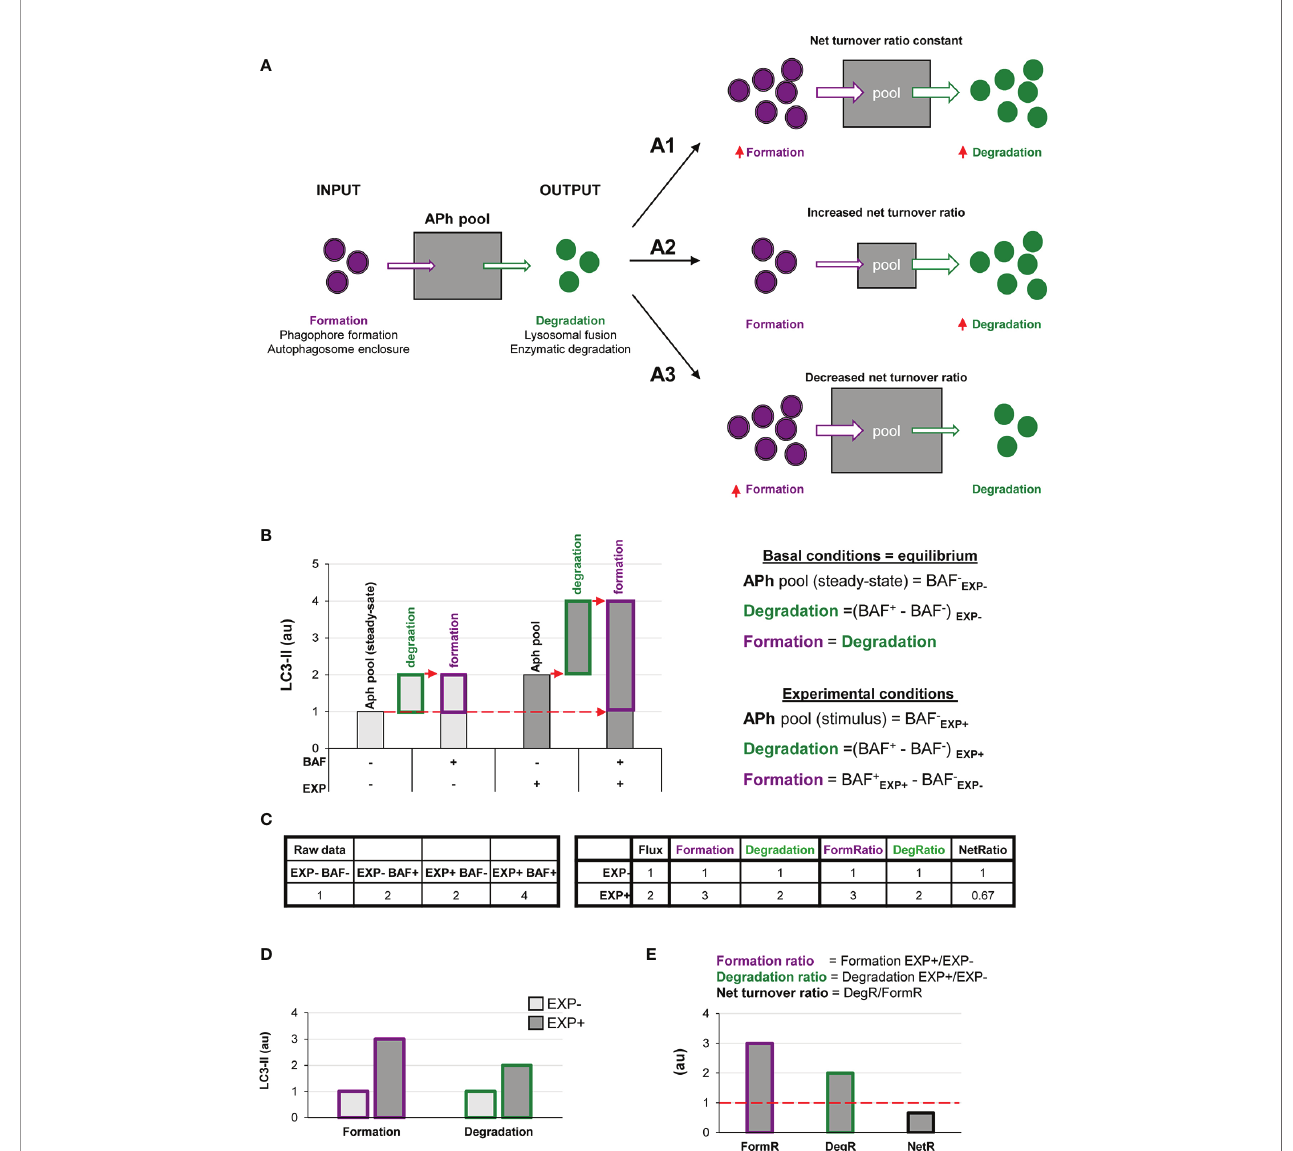
FIGURE 2 | A two-step model of autophagy to analyze formation and degradation of autophagosomes. (A) The model represents the autophagosomes as a box with an input (autophagosome formation, purple dots) and an output (autophagosome degradation, green dots) that determines the autophagosome net turnover. A1 – A3 represent different possible scenarios with no changes (A1), an increase (A2) and a decrease (A3) in the autophagosome net turnover. (B) Graph representing the amount of LC3-II (au, arbitrary units) in two experimental conditions representing (EXP - and EXP + ) in the presence or absence of the lysosomal inhibitor ba fi lomycin (BAF - and BAF + ), and the formulas used to calculate formation, degradation, and net turnover. The dotted red arrows mark the LC3-II raw data values used to calculate the formation and degradation rates and ratios. (C) Simulated raw LC3-II data (au) (left) used to calculate the formation and degradation rates and ratios (right) used in the graphs shown in (B, D , E) . (D , E) Graphs representing the rate of change of formation, degradation and net turnover between the two experimental